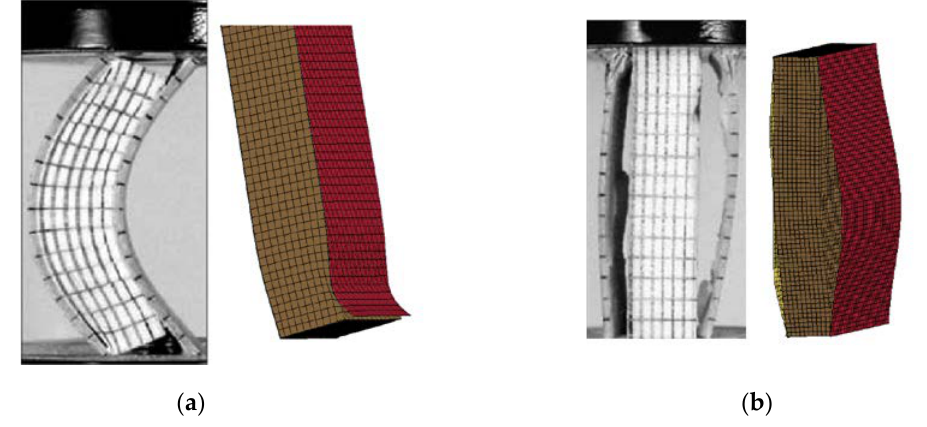
Figure 9. The relationship between load, energy absorption, and displacement with MAT 185.